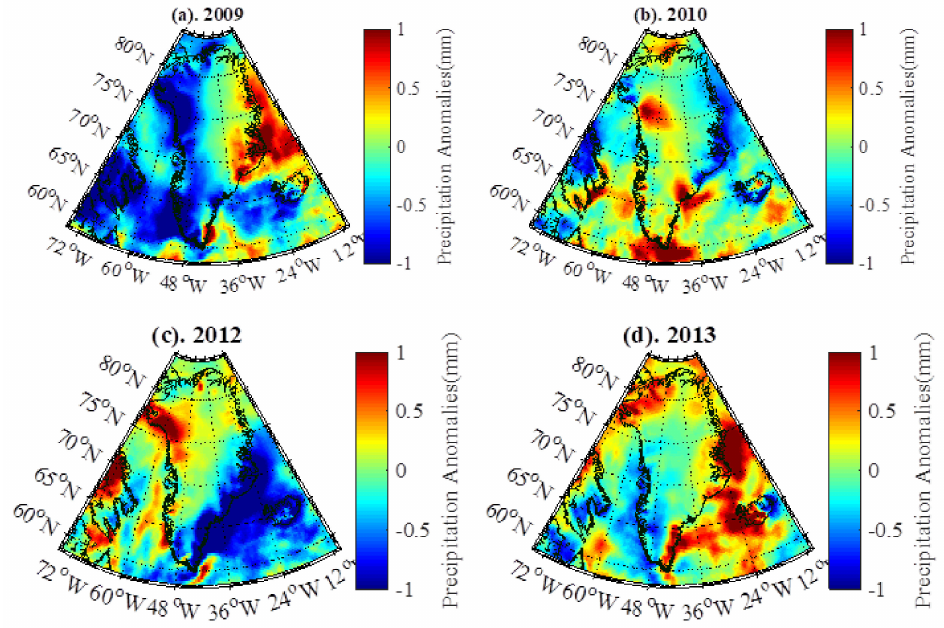
Figure 13. Summer precipitation anomalies (relative to the average over the period 2000-2016) in: ( a ) 2009, ( b ) 2010, ( c ) 2012, and ( d )